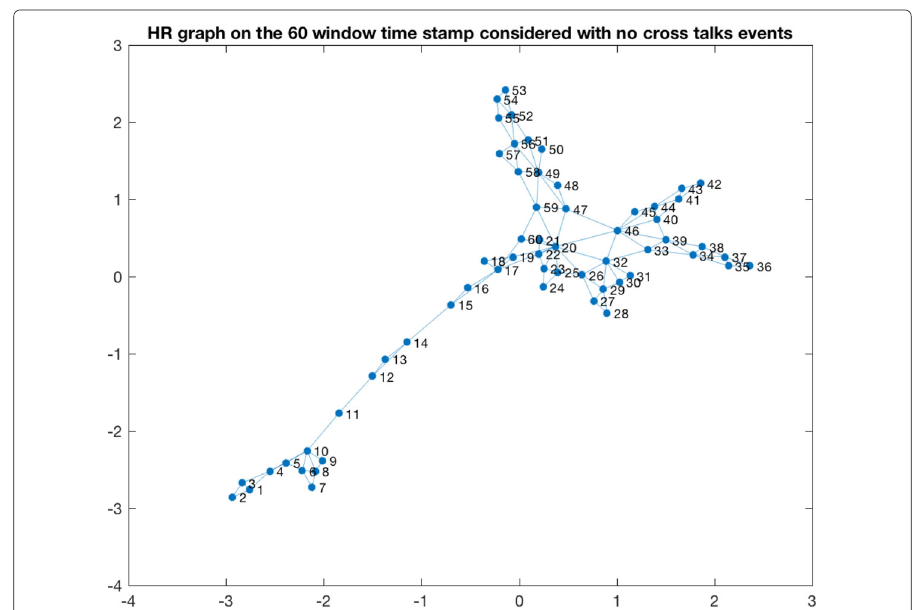
Fig. 8 HR graph with no cross talk. The figure shows the HR horizontal visibility graph corresponding to the time window in which no cross talks events are detected